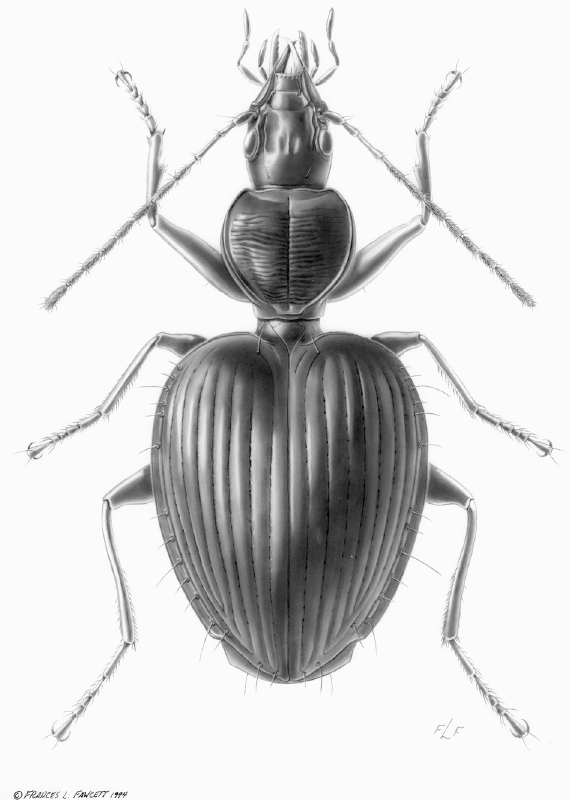
Figure 1. Cyphocoleus subulatus sp. n. male paratype dorsal view: NEW CALEDONIA, Ciu, near Mt. Canala, 300 m